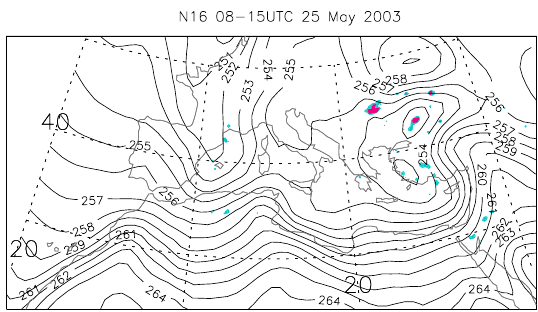
Fig. 10. Same as Fig. 5, but for 25 May 2003,